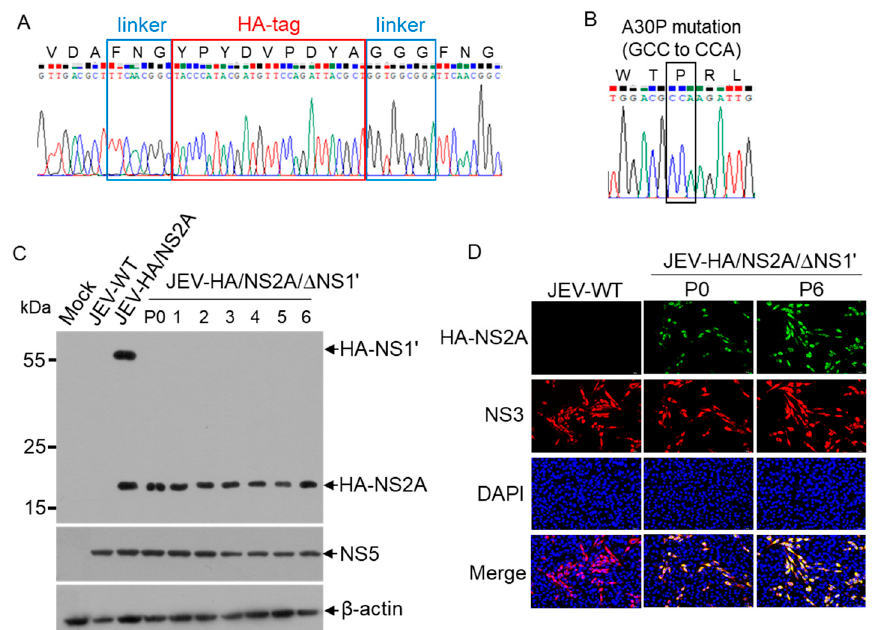
Figure 2. Analysis of stability of JEV-HA/NS2A/ ∆ NS1’. The full-length gene sequence of JEV- HA/NS2A/ ∆ NS1’ was amplified by RT-PCR from passage 6 and subjected to DNA sequencing. ( A ) Sequencing chromatogram of HA-tag insertion. ( B ) Sequencing chromatogram of A30P mutation. ( C , D ) BHK-21 cells were infected with the indicated recombinant JEV and subjected to western blots ( C ) and IFA analysis ( D ). Detection of HA-NS2A expression by IFA. HA-NS2A (green) and NS3 (red) were detected with anti-HA and anti-NS3 antibodies, respectively. The nuclei (blue) were stained with 4’,6-diamidino-2-phenylindole (DAPI).